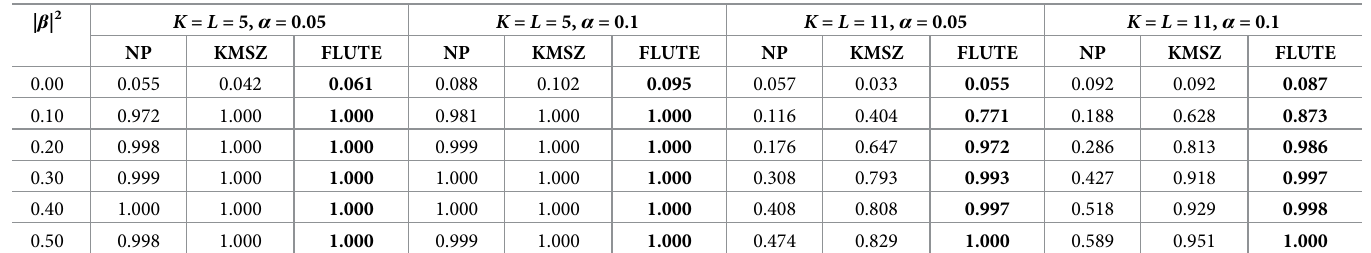
Table 5. Size and power for heteroscedastic variance when K = L = 11, n = 40. | β | 2 K = L = 5, α = 0.05 K = L = 5, α =